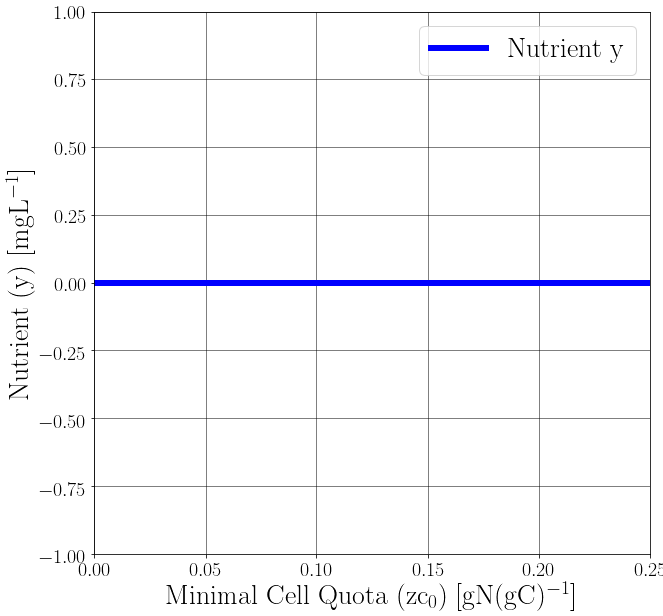
Figure 4. A bifurcation diagram of the nutrient ( y ) vs. minimal cell quota ( zc 0 ). The horizontal axis of this figure indicates the values of the minimal cell quota zc 0 , and the vertical axis indicates the nutrient y values. For each value of zc 0 , the diagram shows the corresponding equilibrium points. Parameters: ρ m = 0.0916 mgN ( mgC ) − 1 d − 1 , k s = 1.7499 mgNL − 1 , µ m = 1.8102 d − 1 , and zc 0 was varied between 0.01 to 0.25. Initial conditions correspond to x 0 = 91.483 mgCL − 1 , y = 14.5148 mgNL − 1 , z 0 = 0.0347 mgN ( mgC ) − 1 . Parameter data were obtained from [48]. We performed simulation and plotting in Octave 5.1.0.0 and Python 3.7.1.